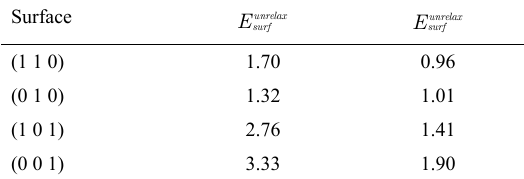
Table 1: Surface energy (in Jm -2 .) of unrelaxed and relaxed surfaces Surface